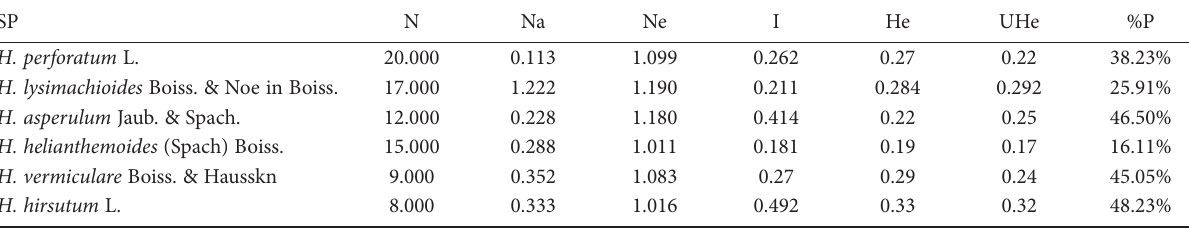
Table 3. Genetic diversity parameters in the studied Hypericum species. SP N Na Ne